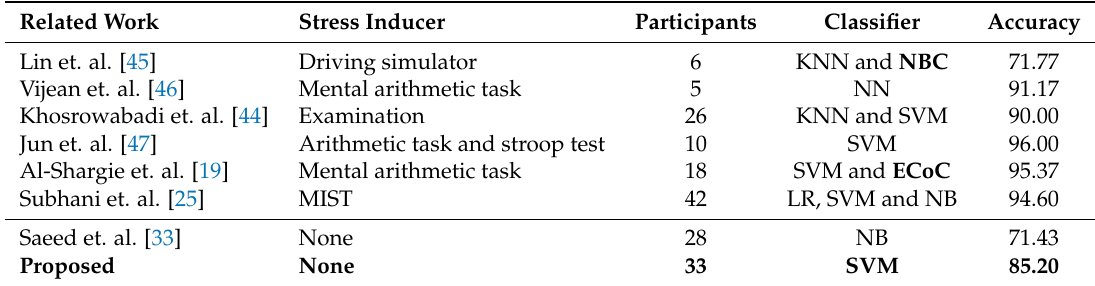
Table 7. Comparison of results with previously related EEG-based